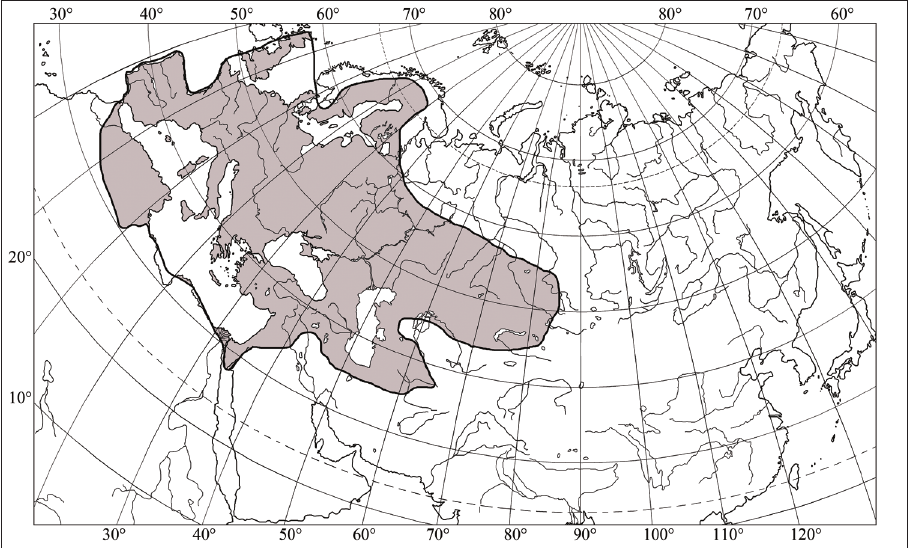
Figure 2. Range of Eurygaster maura (Linnaeus, 1758) (after Göllner-Scheiding 2006 and Vinokurov et al.